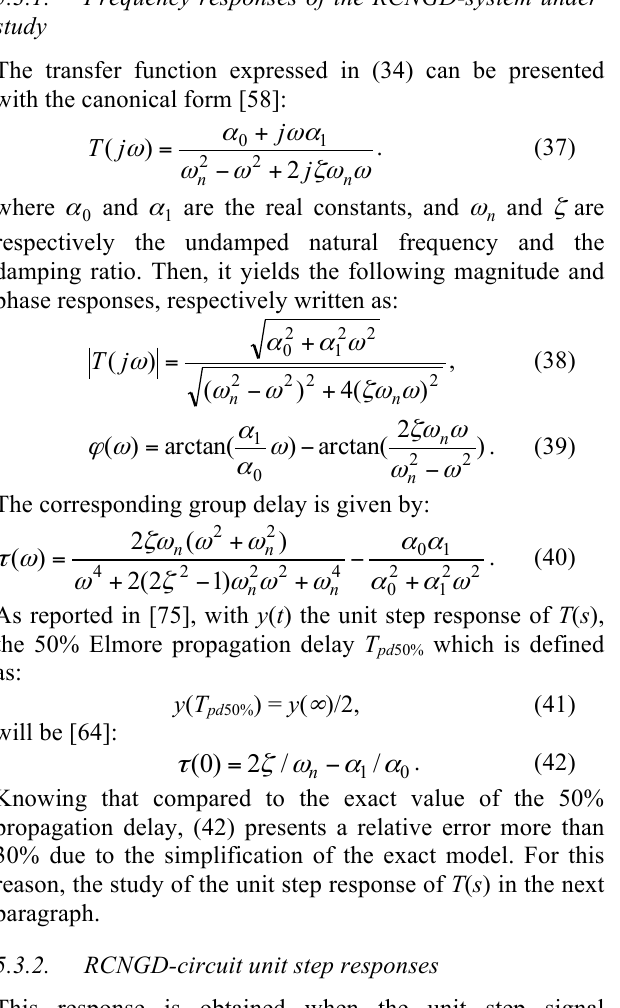
Figure 14: Three types of the unit step response of system (37) according to the damping factor ζ